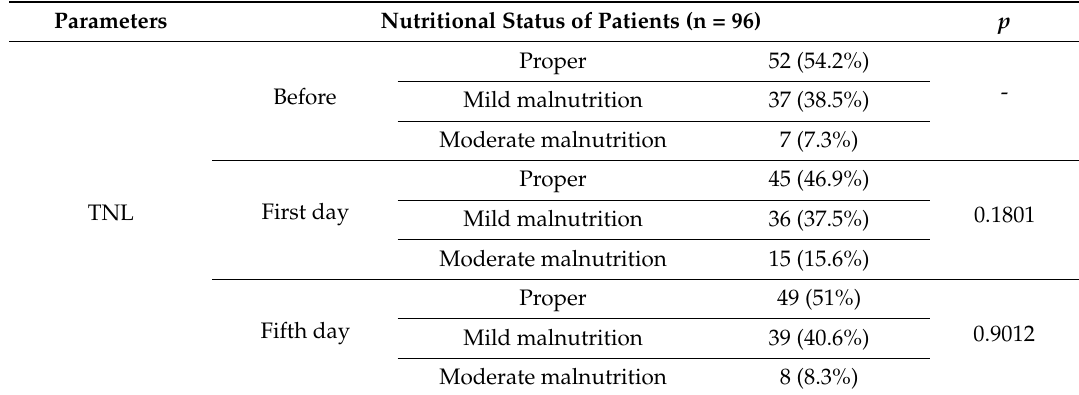
Table 2. Nutritional status of patients based on TNL.